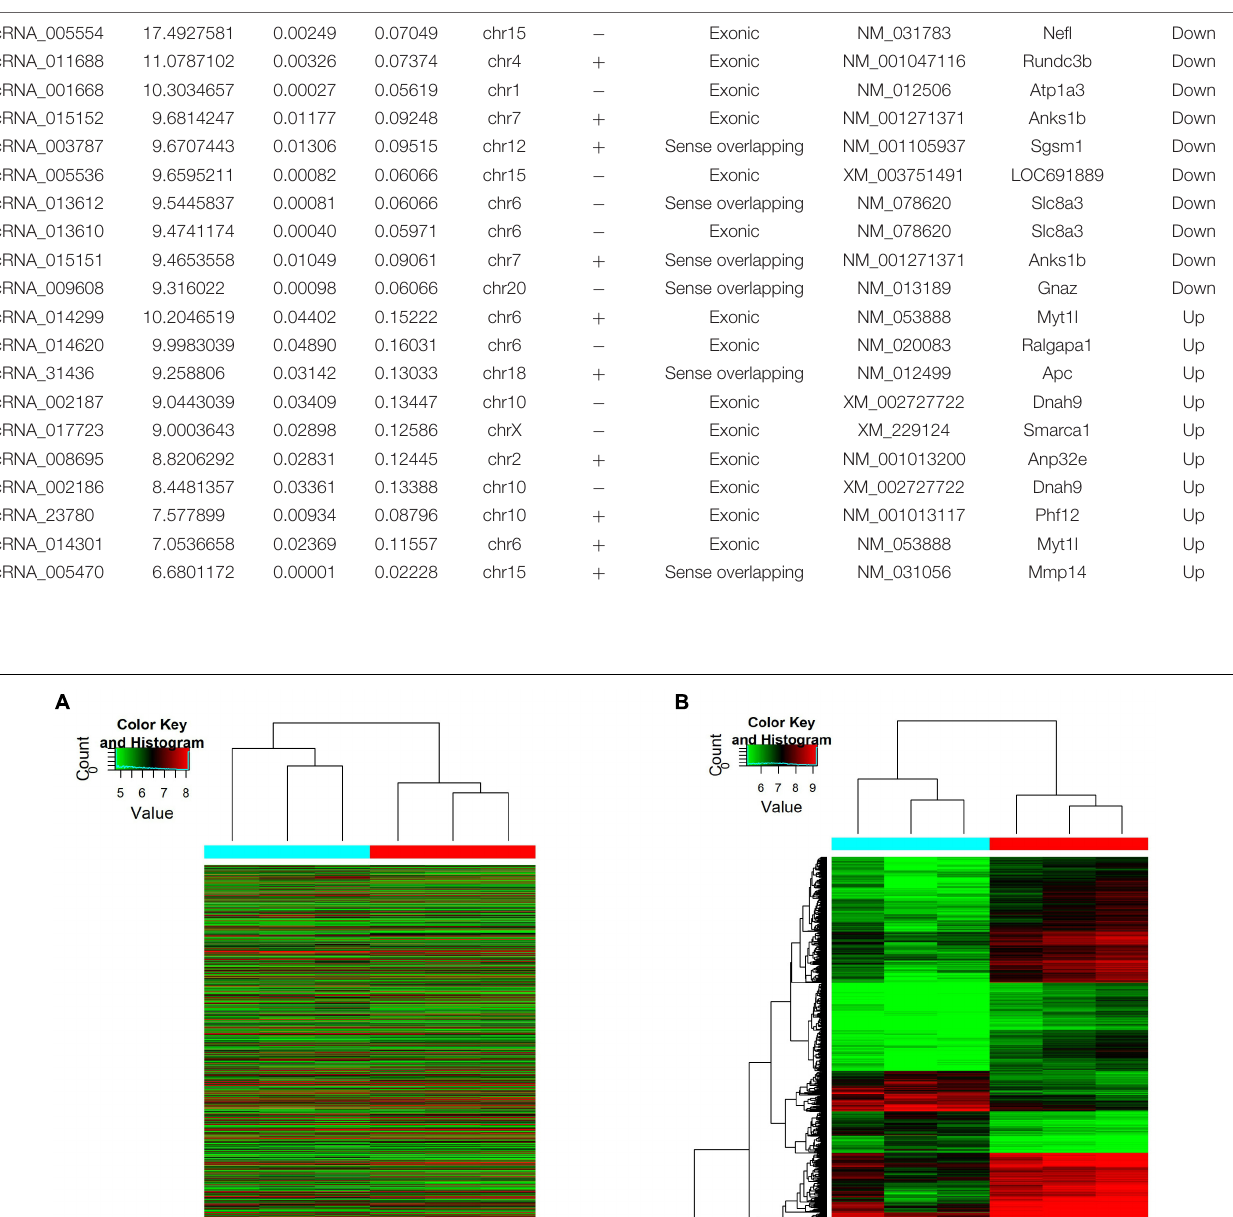
TABLE 1 | The top 10 up-regulated and down-regulated circRNAs ranked by fold changes after SCI. CircRNA FC P -value FDR Chrom Strand